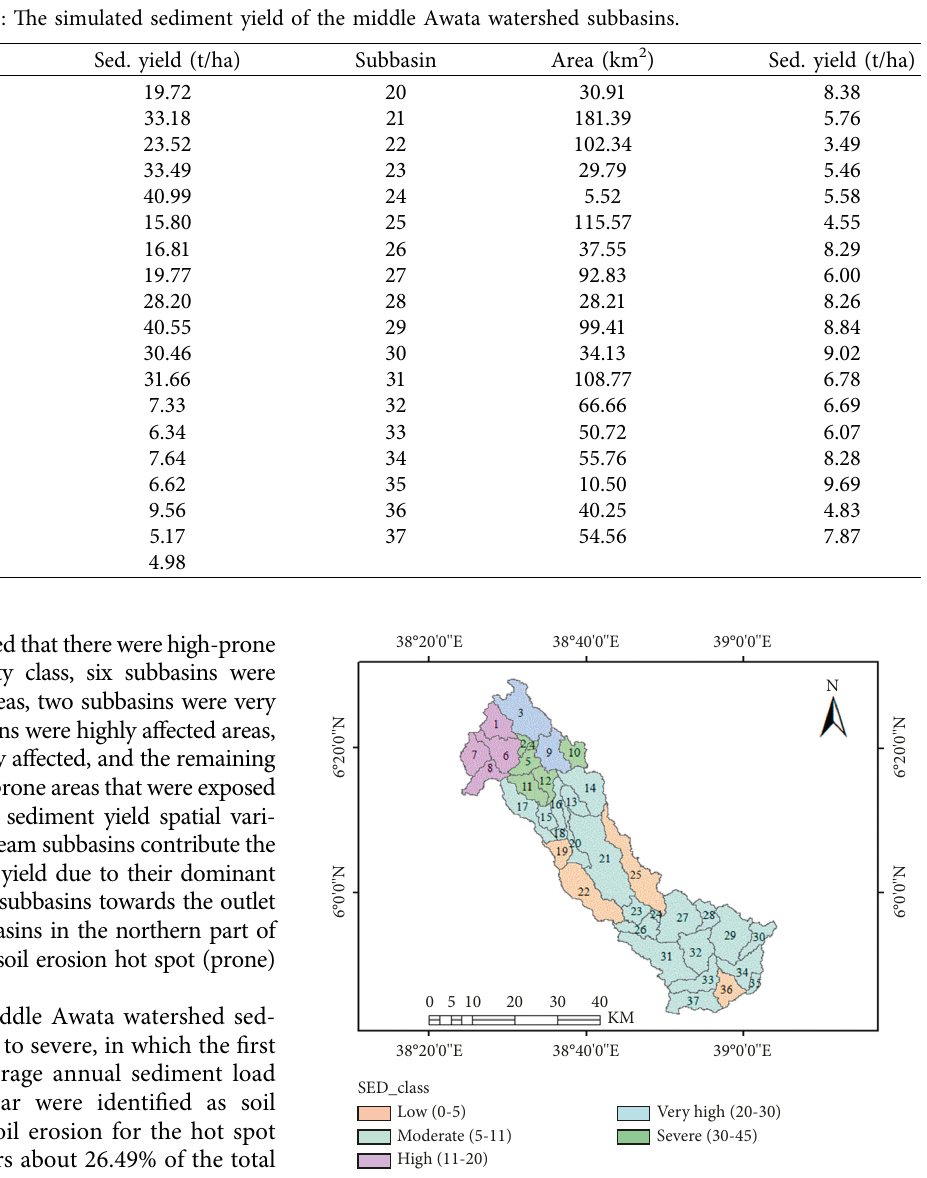
Figure 15: Spatial variability map of sediment yield in the middle Awata watershed.